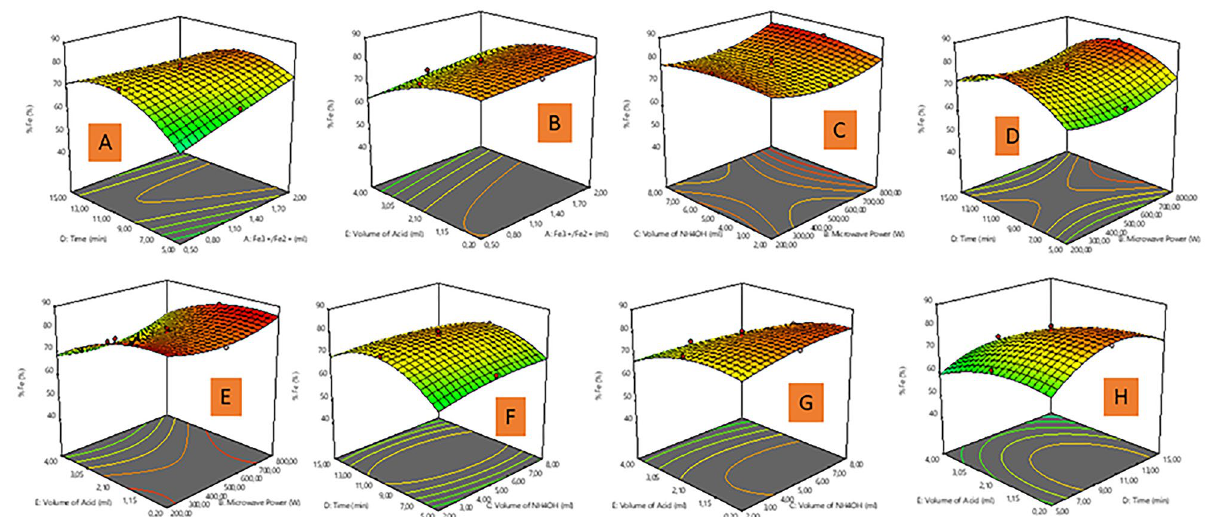
Figure 2. 3D response plots of ( A ) Fe 3+/ Fe 2+ solution and time, ( B ) Fe 3+/ Fe 2+ solution and volume of oleic acid, ( C ) microwave power and volume of ammonium hydroxide, ( D ) microwave power and time, ( E ) microwave power and volume of oleic acid, ( F ) volume of ammonium hydroxide and time, ( G ) volume of ammonium hydroxide and volume of oleic acid, ( H ) time and volume of oleic acid on % Fe the preparation parameters (Fe 3+ /Fe 2+ solution, microwave power (MP), reaction time, and volume of oleic acid (VOA)) on % Fe content in accordance with the ANOVA (Table S1) are discussed. In Fig. 2A, the % Fe content of the MNP-OA composite increased with an increase in Fe 3+ /Fe 2+ solution against the time from 0.5 to 1.25 ml,